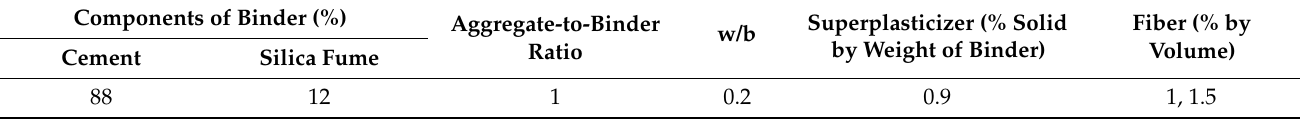
Table 3. Mix proportion of ultra-high performance concrete (UHPC).